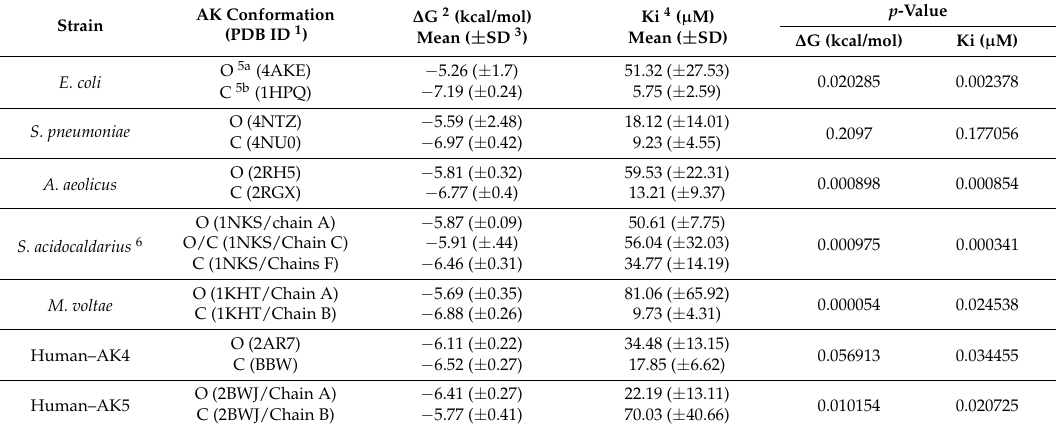
Table 1. The binding energies (kcal/mol) and inhibition constants ( µ M) of the unliganded AKs or of the enzyme in complex with the substrates or substrate